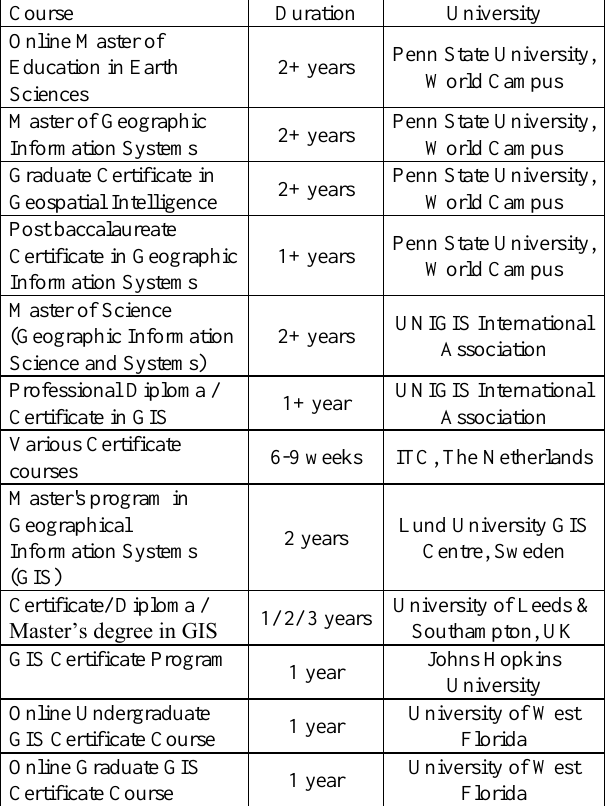
Table 3. Major Distance Education Programs at